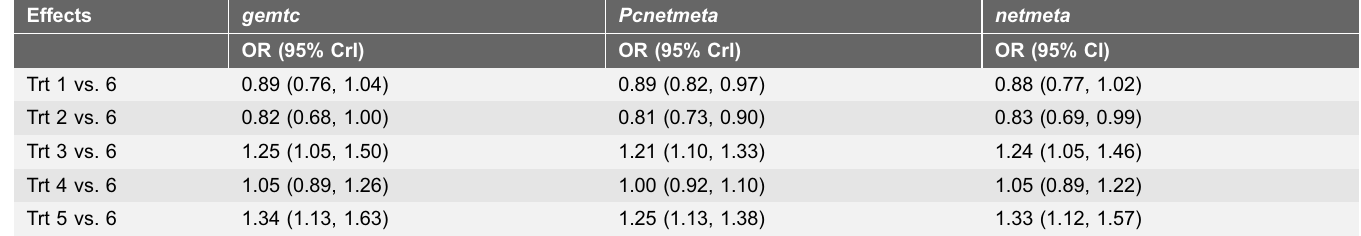
Table 6. Estimates of odds ratios and 95% credible or confidence intervals of treatment effects in Diabetes data by three R packages.